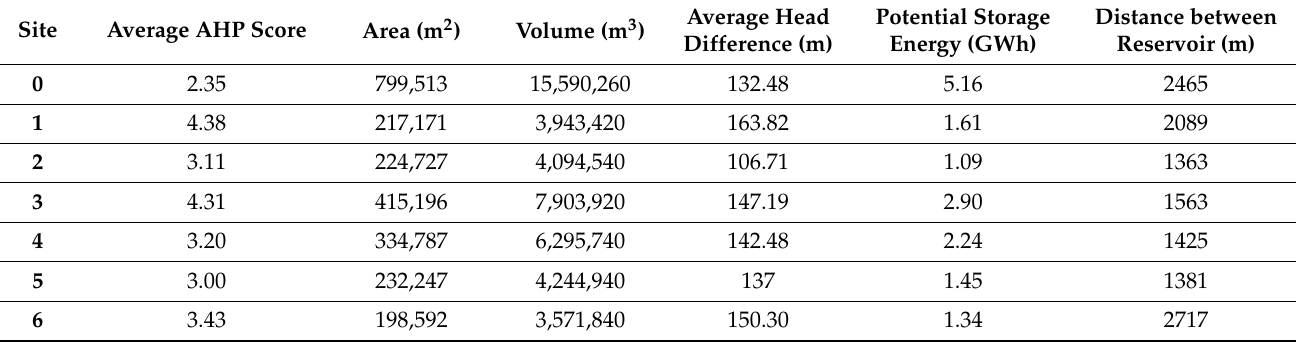
Table 6. Statistical results of AHP scoring for the suggested upper reservoir locations.